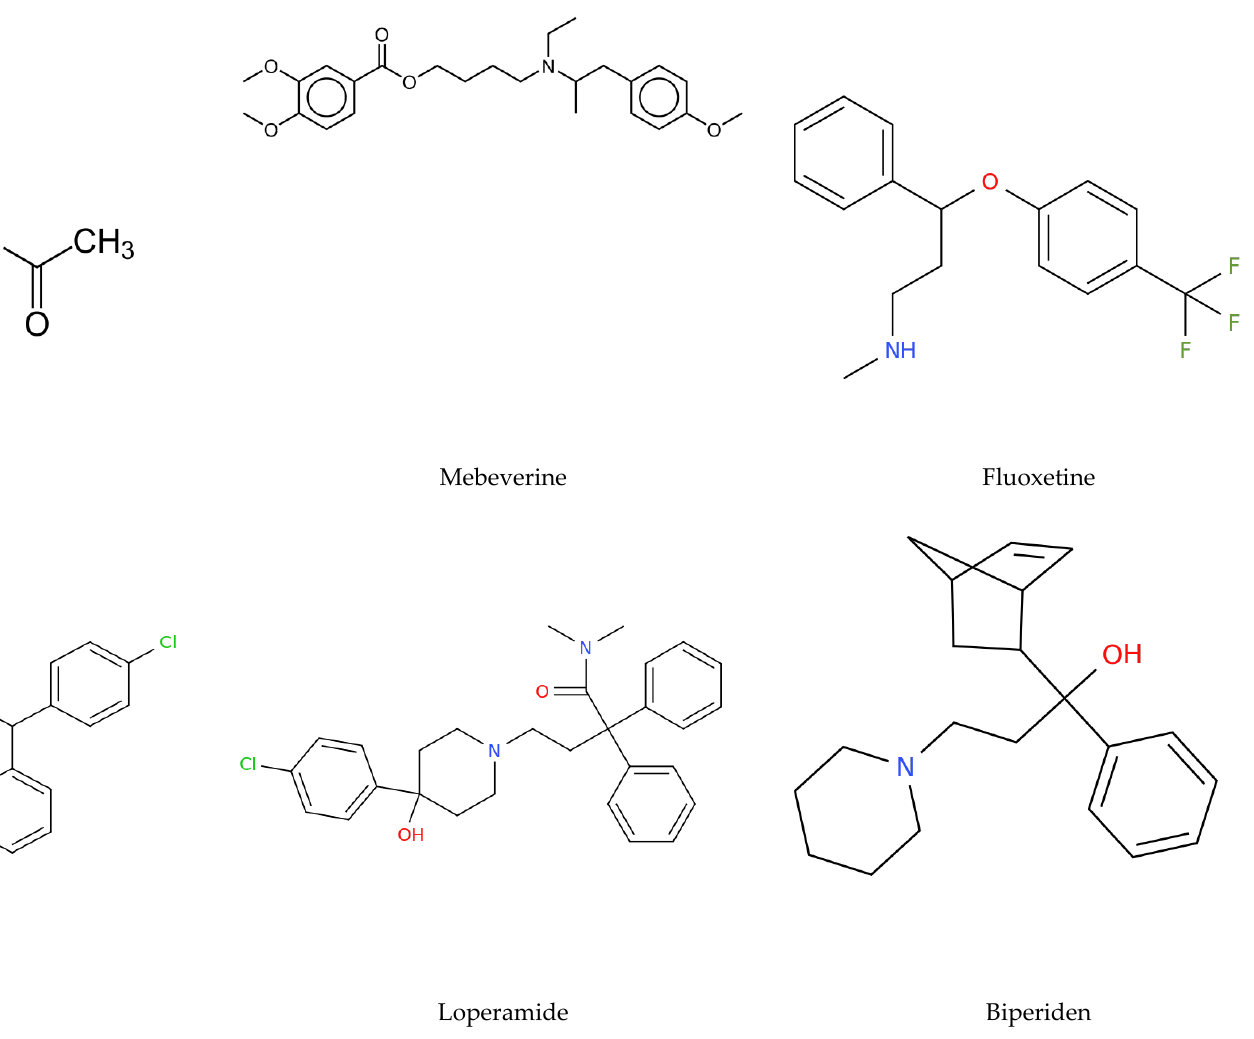
Figure 1. Chemical structures of the twelve FIASMAs.